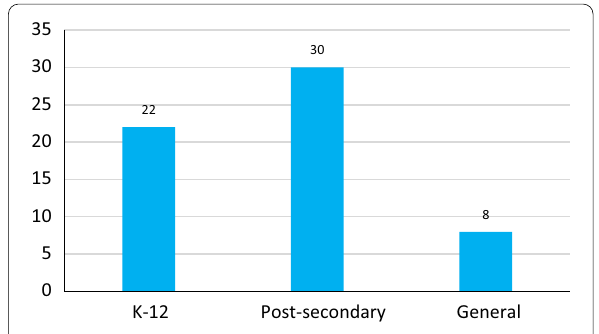
Fig. 6 Publication distribution by school